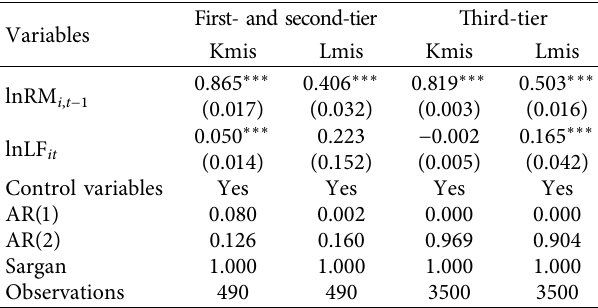
Table 2: Estimation results for the urban tier sample based on the SYS-GMM